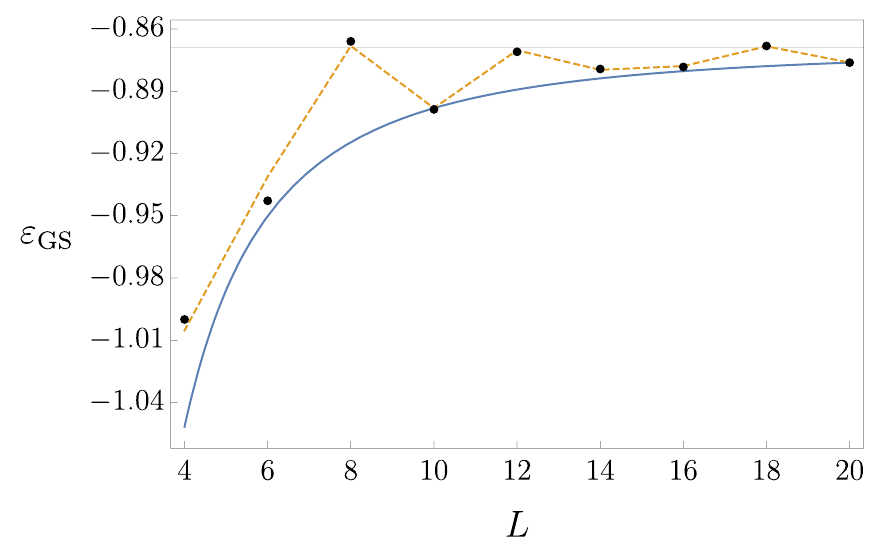
Figure 5: The ground state energy per unit length (cid:34) GS = E GS / L as a function of the chain’s length L (black dots). The dashed orange piecewise linear curve is predic- tion (132). The horizontal grey line is the energy density in the thermodynamic limit. The blue curve includes only the leading CFT correction